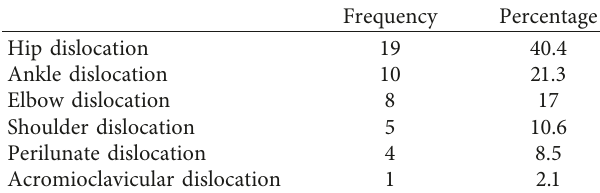
Table 8: Joint dislocation distribution, n � 47